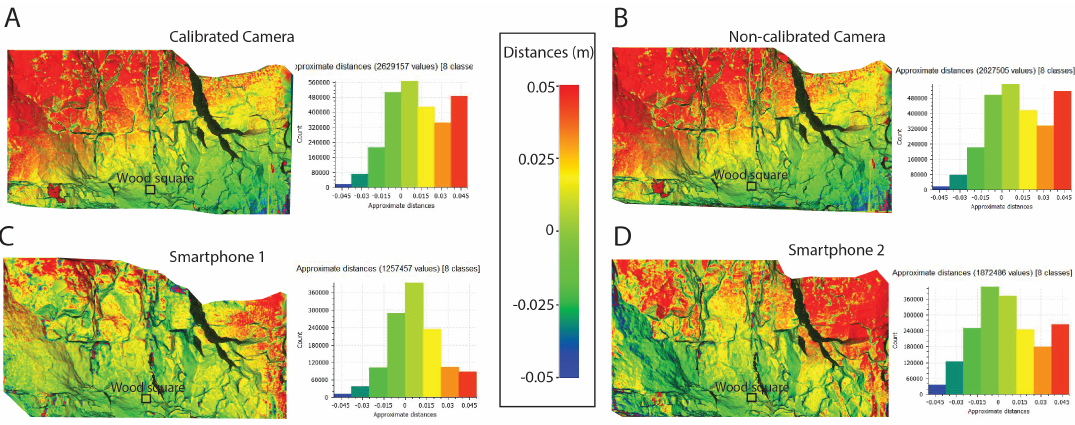
Figure 12. Comparison between LS and DP obtained with a calibrated digital camera ( A ), non-calibrated digital camera ( B ), smartphone 1 ( C ) and smartphone 2 ( D ). All models were georeferenced using the three targets 0, 5, and